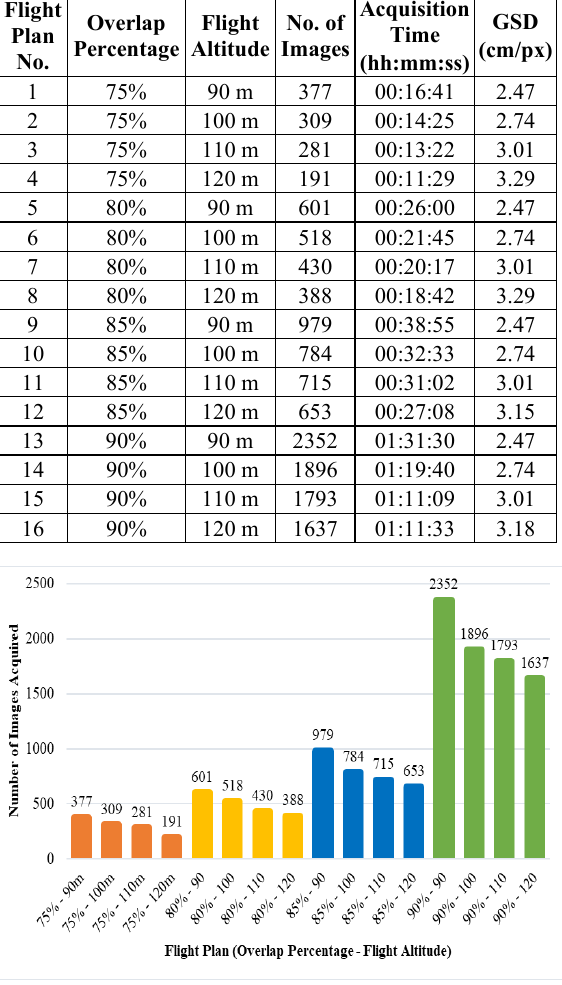
Table 4 . Summary of the Acquired UAS Images